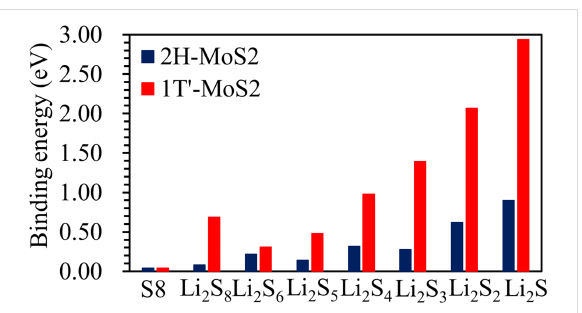
Figure 2: The calculated binding energies of Li 2 S x on 2H-MoS 2 and 1T'-MoS 2 monolayers.